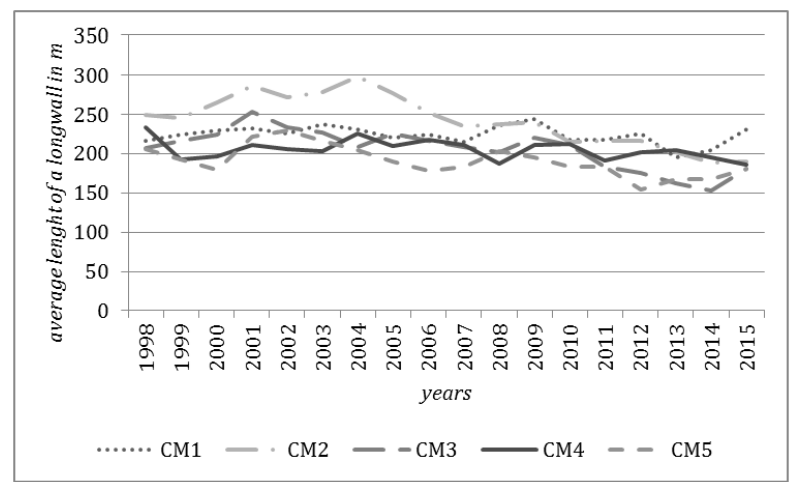
Figure 6. Average number of longwalls in the examined coalmines over the period 1998–2015. Source: own work.